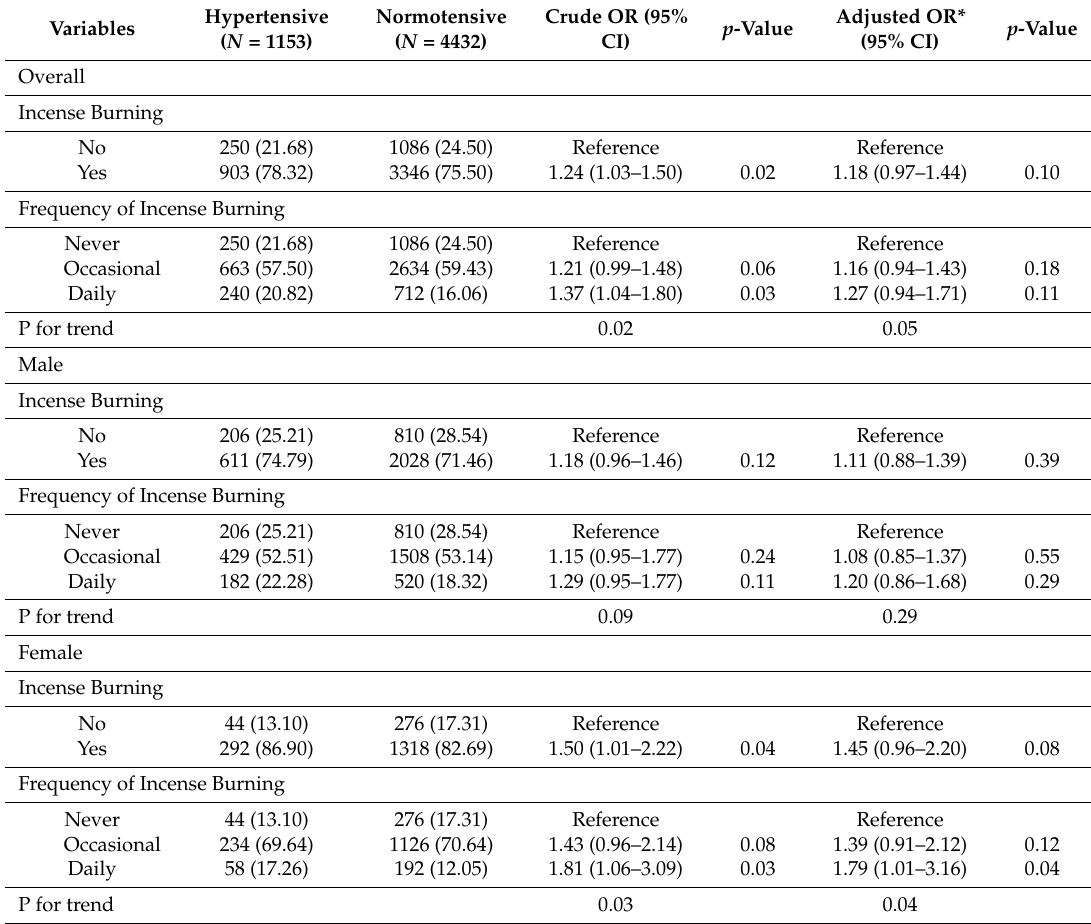
Table 2. Association between domestic incense burning and hypertension